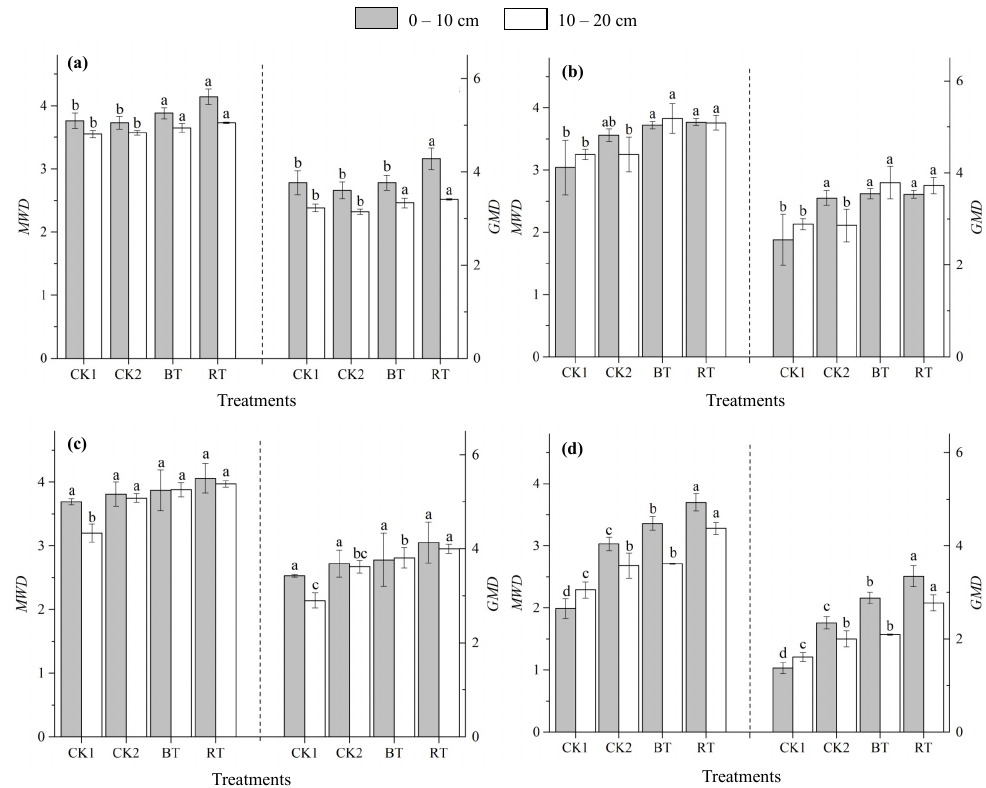
Figure 6. The MWD and GMD at the ( a ) flowering stage, ( b ) maturity stage of rape, ( c ) heading stage, and ( d ) maturity stage of rice under different tillage modes. Different lowercase letters in the same line represent significant differences between treatments ( p < 0.05).